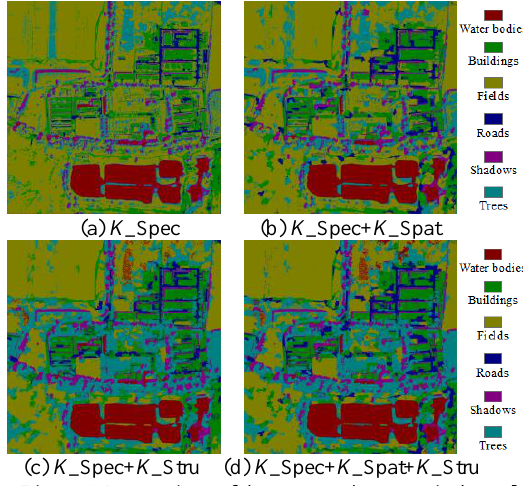
Figure 5 Comparison of the proposed composite kernel approach with other kernel-based methods